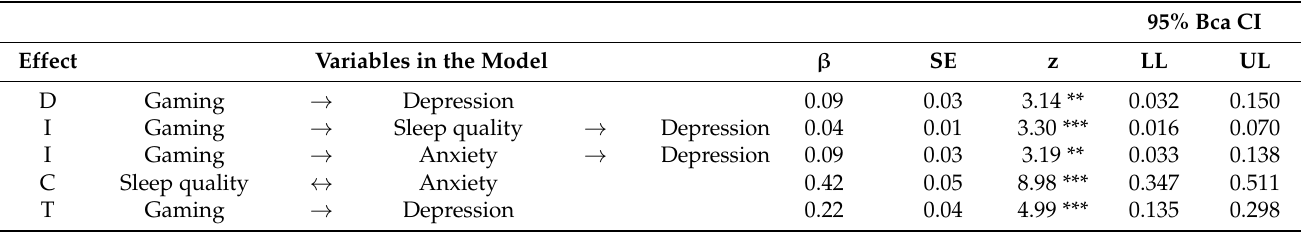
Table 6. Model 1 of mediating effects of sleep quality and anxiety on the relationship between gaming and depression in the sample of undergraduates ( n = 457).